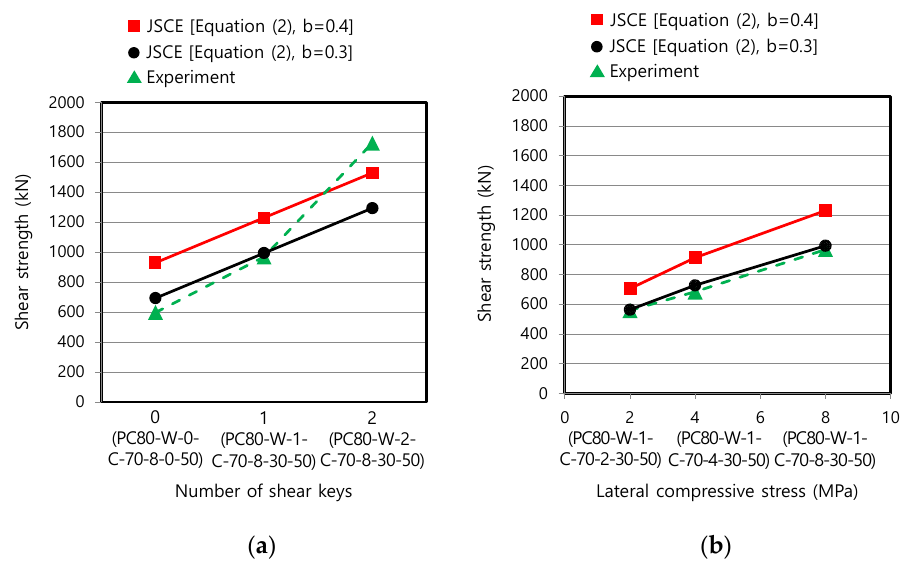
Figure 10. Comparison of test data with predictive equation of JSCE [22,24] for each variable (wet joint with ultra-high-strength concrete filler): ( a ) number of shear keys; and ( b ) lateral compressive stress.